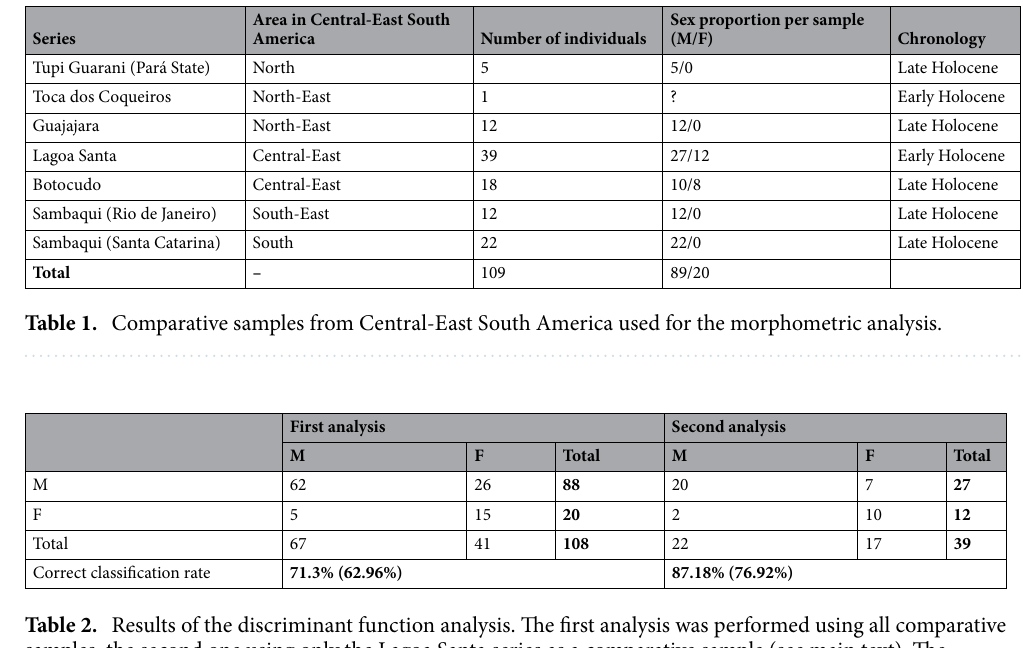
Table 2. Results of the discriminant function analysis. The first analysis was performed using all comparative samples, the second one using only the Lagoa Santa series as a comparative sample (see main text). The percentages in parenthesis correspond to the cross-validated rate of correct classification.